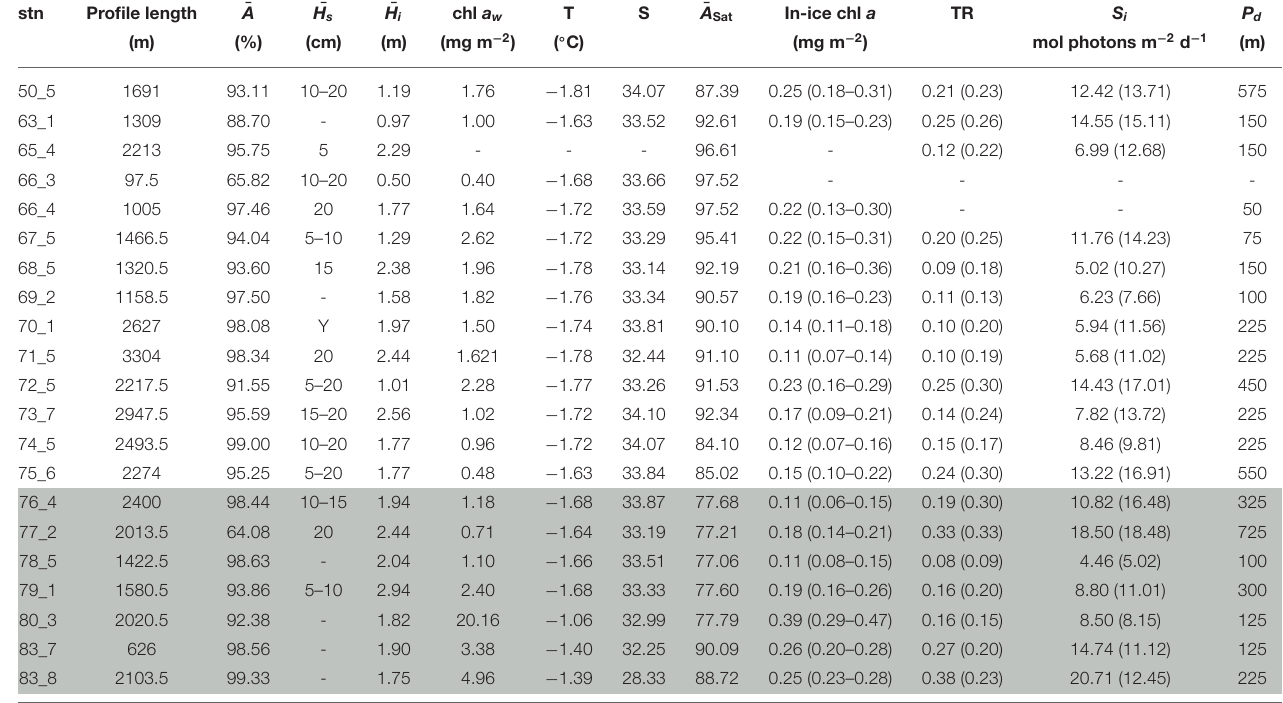
TABLE 4 | Table for PS106 with, for each station (stn), the total profile length, the mean ice concentration ( ¯ A ) along profile, mean snow depth ( ¯ H s ) and mean total ice thickness ( ¯ H i ), under-ice water chl a (chl a w ) multiplied by the vertical section of the SUIT (2m) to obtain integrated values, under-ice water temperature and salinity, ice concentration retrieved from satellite ( ¯ A Sat ), and median in-ice chl a (interquartile range), mean transmittance TR ( ± one standard deviation), mean Insolation S i ( ± one standard deviation), and the draft patch size ( P d